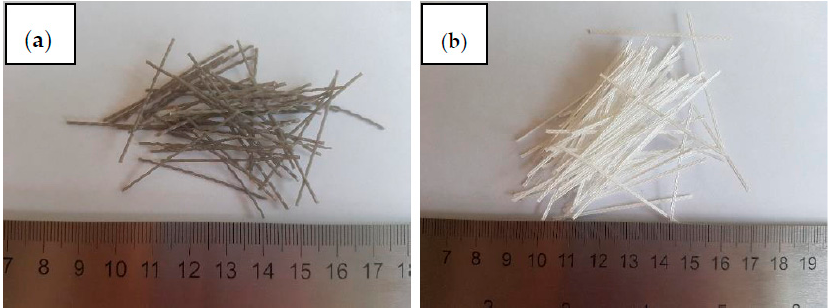
Figure 4. Polypropylene recycled fibers: ( a ) green polypropylene fiber (PPG) and ( b ) white polypropylene fiber (PPW).